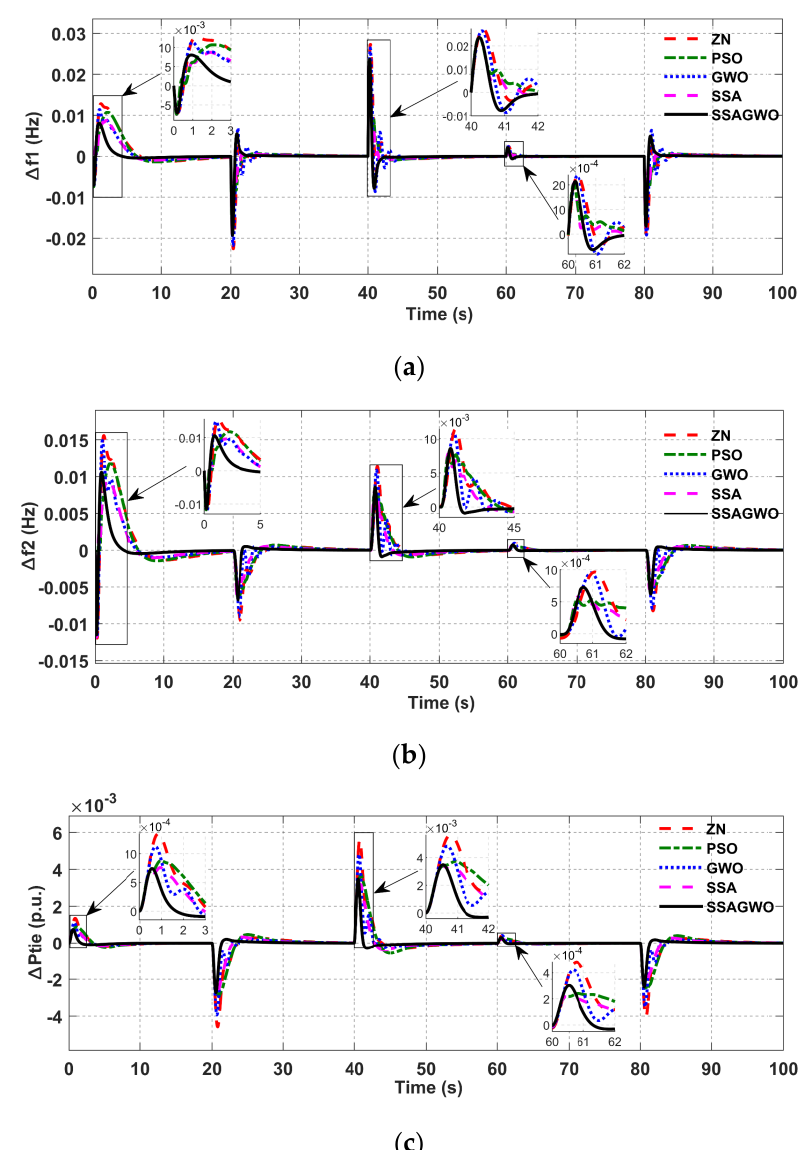
Figure 12. Random change load.